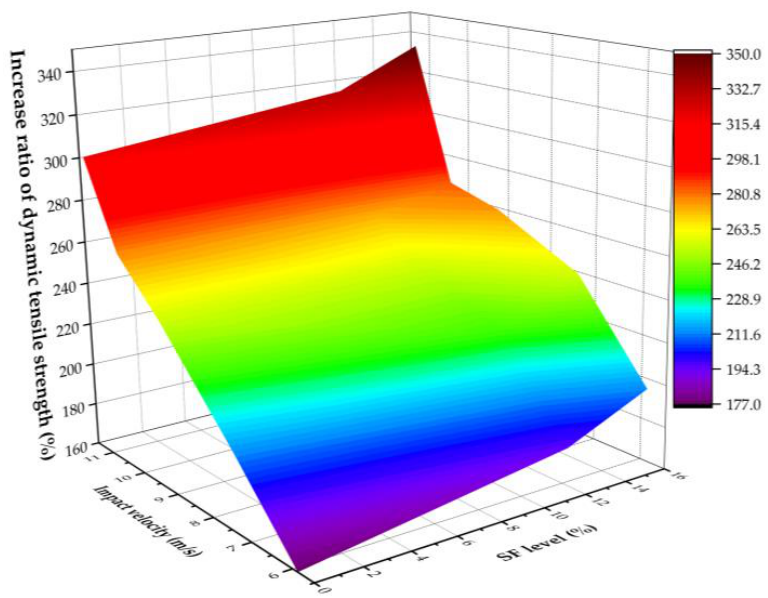
Figure 10. The increase ratio of dynamic tensile strength under different impact velocities and SF levels.